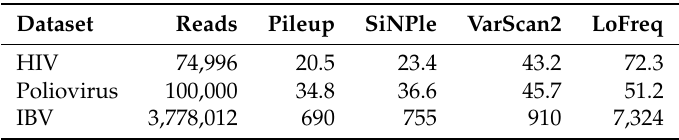
Table 3. Time taken in seconds to process the IBV, HIV and poliovirus datasets on a single core using default settings. The time is the average of three runs, and figures for SiNPle and VarScan2 include the time spent on generating the pileup with samtools pileup . For LoFreq, pileup generation is not a factor as LoFreq works directly with BAM